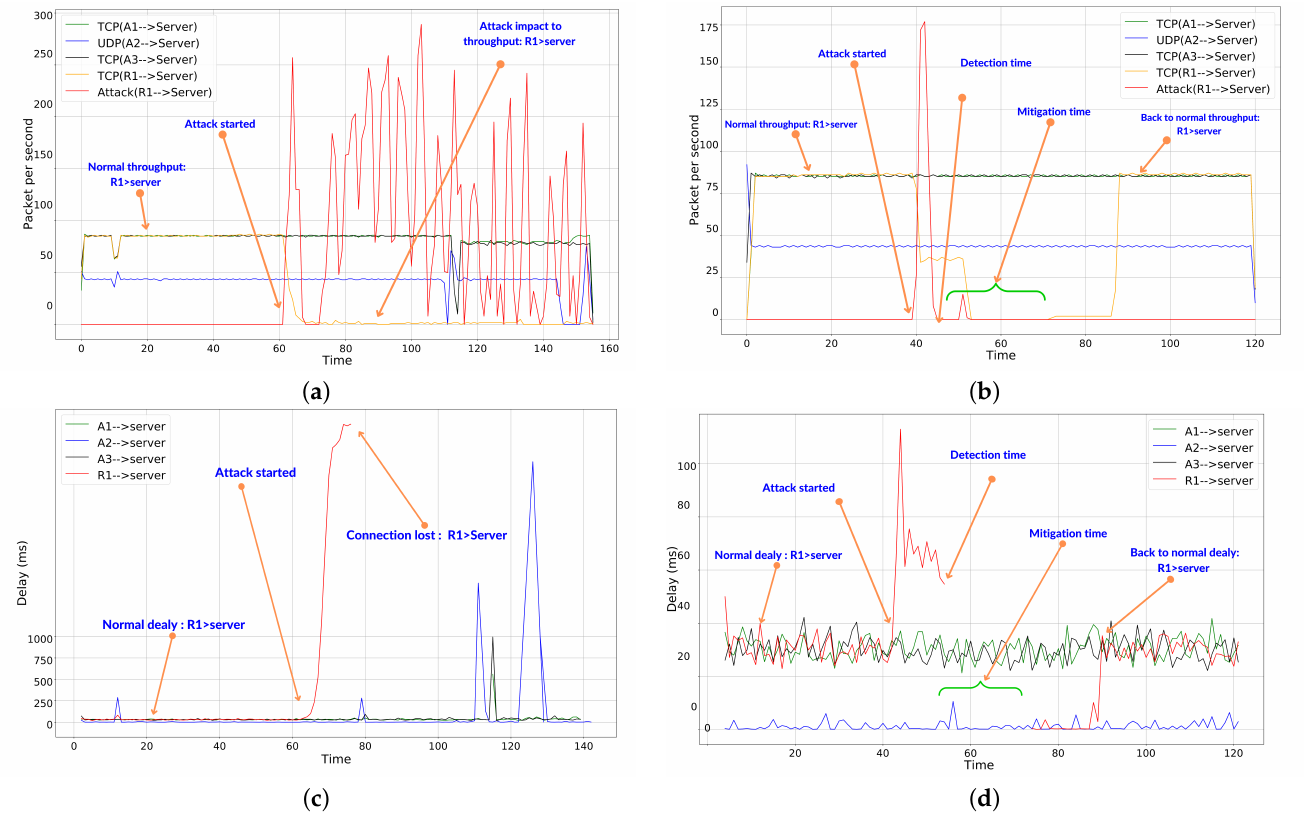
Figure 16. Impact of selected model on delay and throughput of FON: ( a ) throughput (without miti- gation); ( b ) throughput (with mitigation); ( c ) delay (without mitigation); ( d ) delay (with